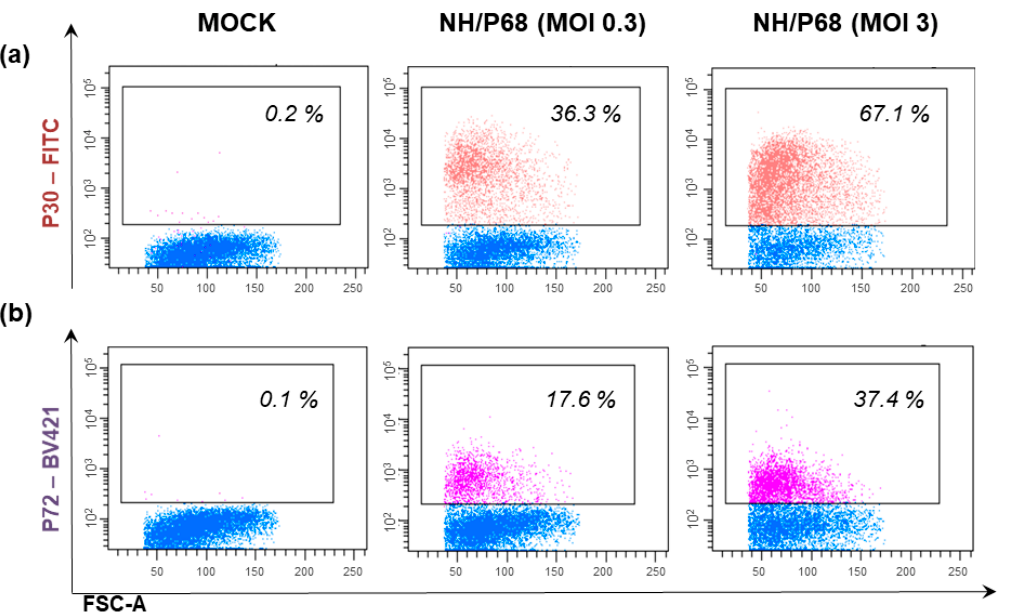
Figure 2. NH/P68 infection of COS-1. COS-1 cells were infected with the low virulence NH/P68 ASFV isolate using an MOI of 0.1 or 1, alongside mock-infected controls. At 24 h pi, the percentages of ASFV early protein p30 ( a ) or late protein p72 ( b ) cells were assessed by flow cytometry. Repre- sentative dot plots are displayed to demonstrate the p30 and p72 labeling of COS-1 infected with different MOI of NH/P68 ASFV.